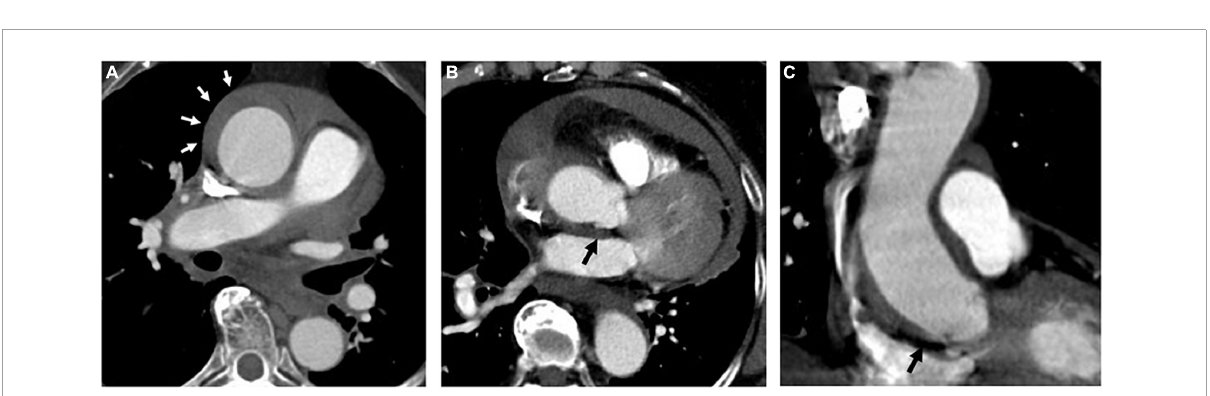
FIGURE2 A 74-year-old woman with TAIMH and unnoticeable ULP. A contrast CT scan showed an ascending aorta aneurysm (52 mm) with a circular aortic wall thickening (9 mm) (white arrow) (A) . Contrast-enhanced CT scan in the axial (B) and coronal view (C) showed an ULP (black arrow) at the ascending aorta just above the aortic root. The patient suffered from sudden death on the first day of admission. CT, computerized tomography; TAIMH, type A aortic intramural hematoma; ULP, ulcer-like projection.